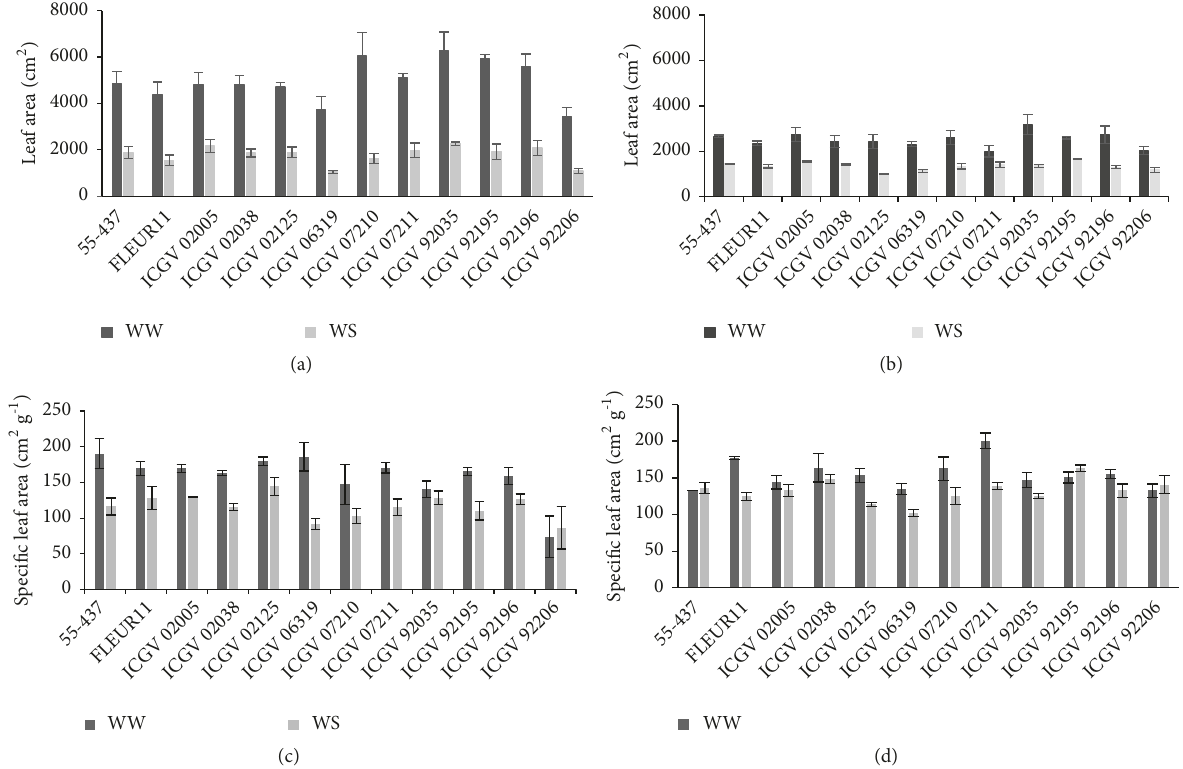
Figure 1: Leaf area (LA) and specific leaf area (SLA) of groundnut genotypes under WW and WS treatments in year 1 ((a) and (c)) and year 2 ((b) and (d))